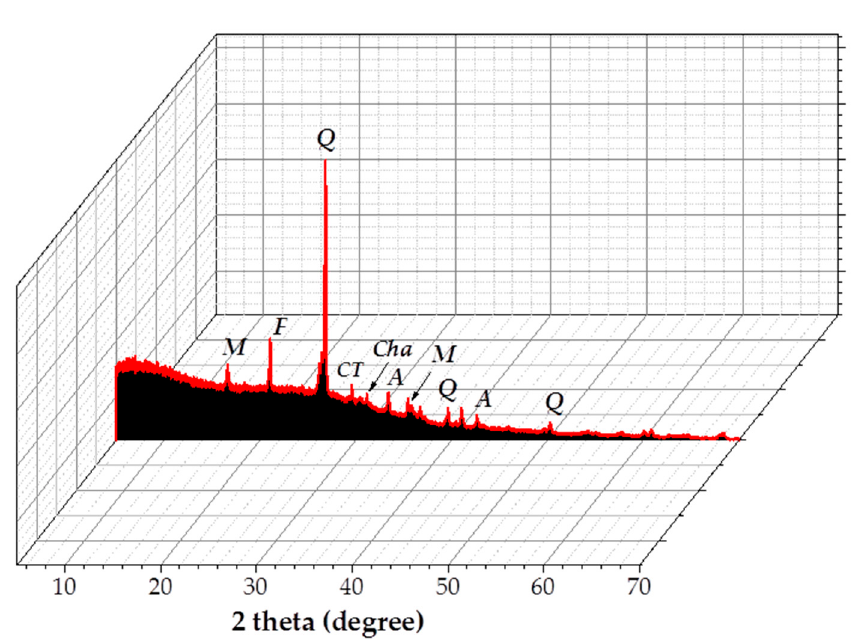
Figure 2. X-ray diffraction pattern.